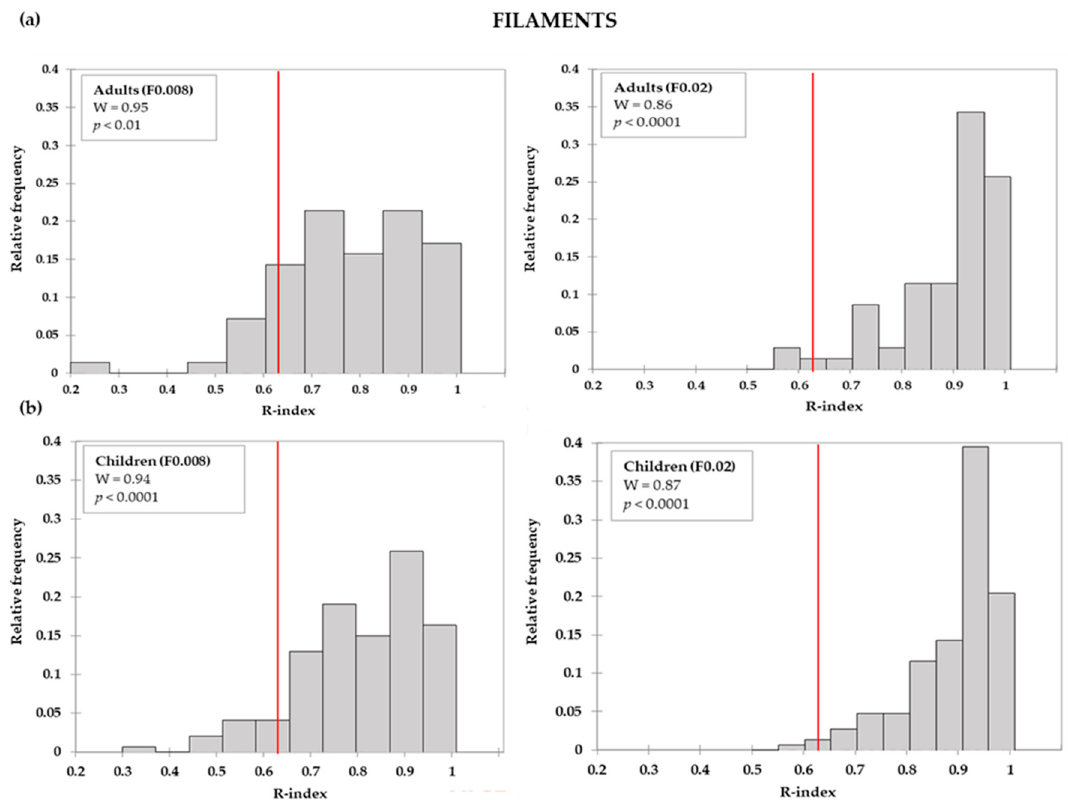
Figure 2. Adults ( a ) and children ( b ) R-index distributions for filaments (F). The vertical lines indicate the R-index cut-offs for discrimination ( R = 0.63). The boxes show the Shapiro-Wilk test (W) statistics and respective level of significance.